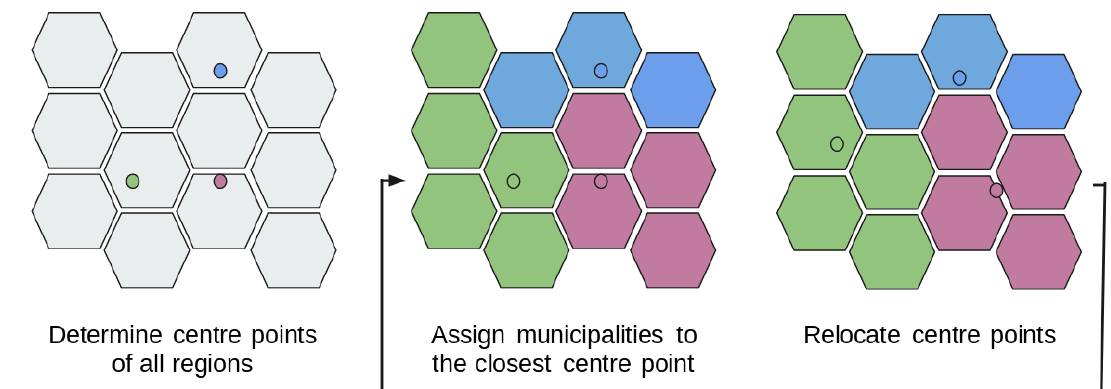
Figure 1. Visual representation of the steps taken to assign municipalities to spatially clustered regions using the k-means algorithm. This algorithm can be applied to generate different numbers of regions. This number of regions is controlled by the variable k . To be able to compare the generated regions with a certain set of identity regions, this k is set equal to the number of regions present in this set of identity